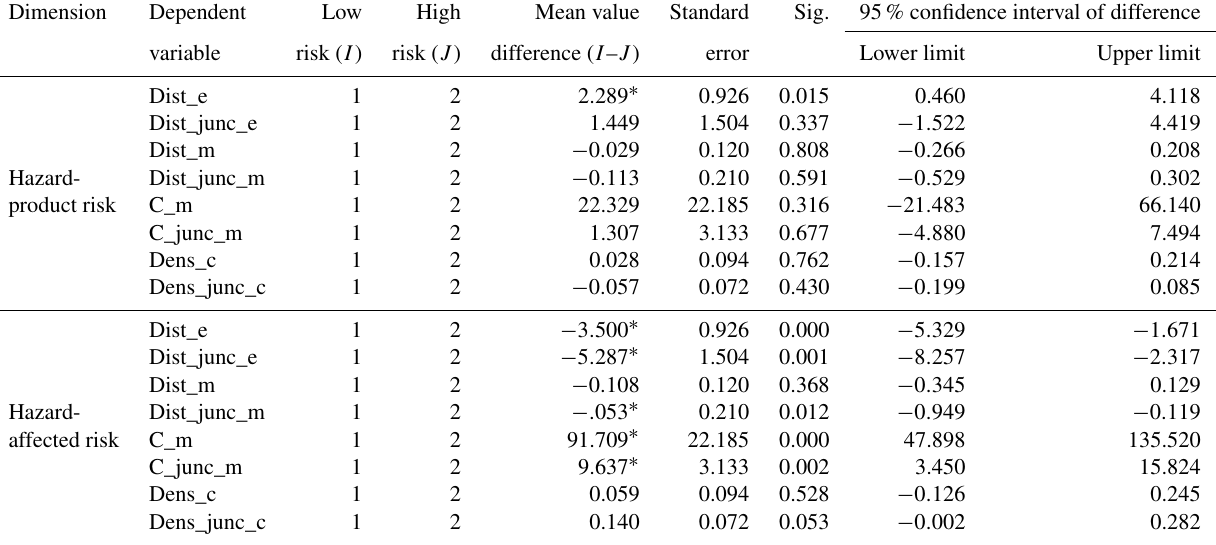
Table 5. List of paired comparisons. Dimension